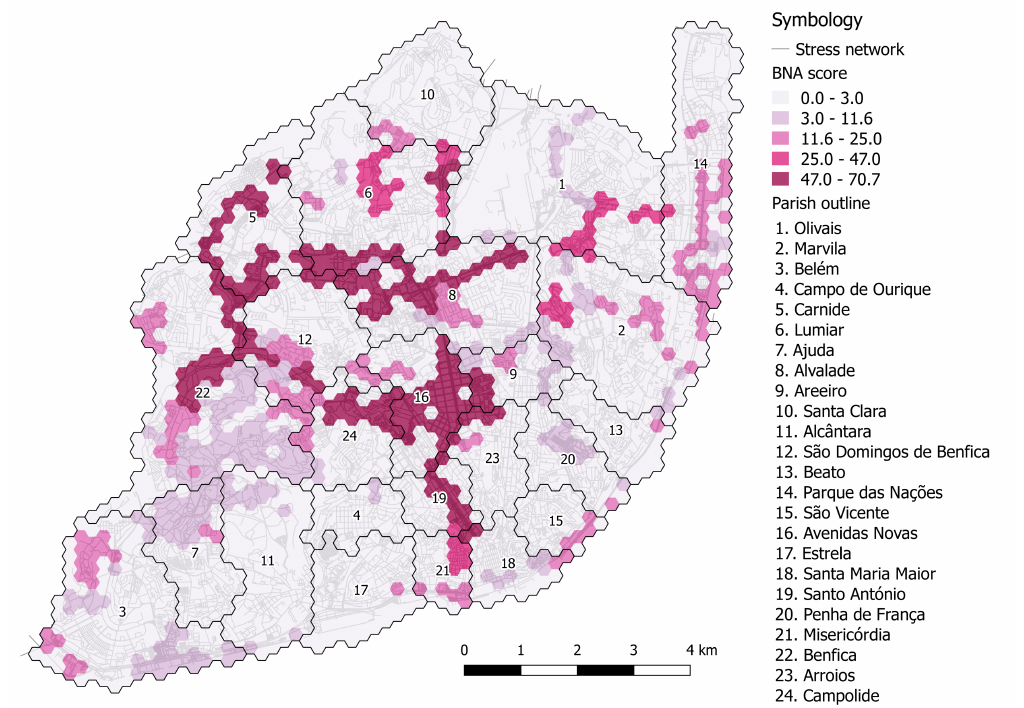
Figure 4. BNA score results for the city of